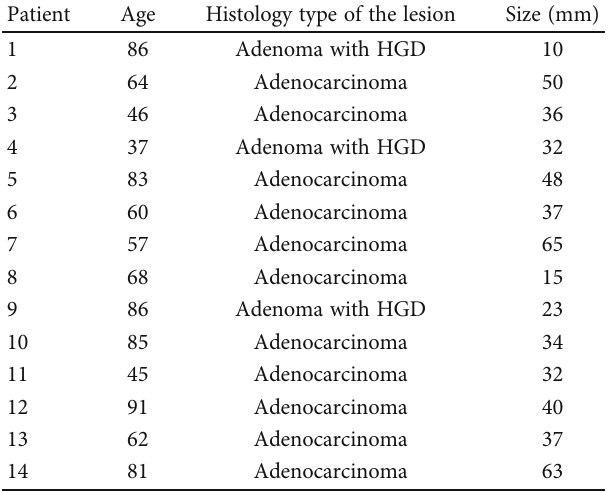
Table 1: Histology type and size of the lesions.